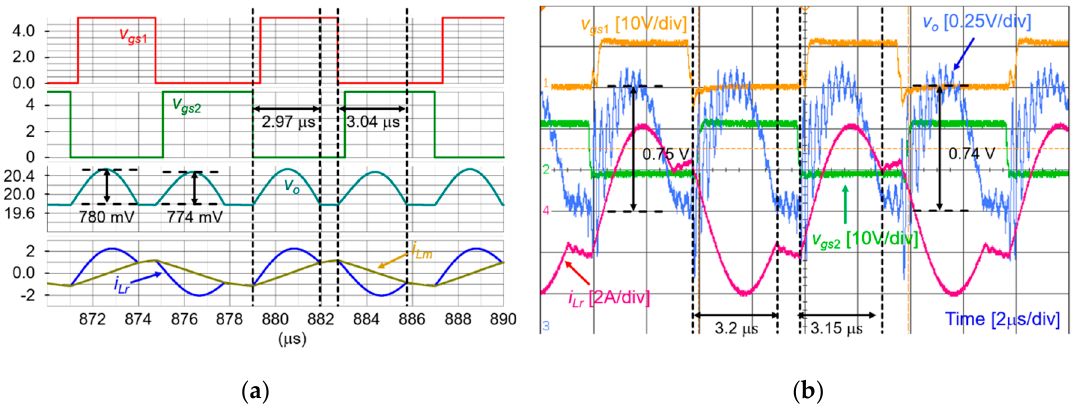
Figure 20. Mismatched secondary side leakage inductances at full load in steady-state operation with the flux-balance loop control ( a ) simulation results and ( b ) experiment results.